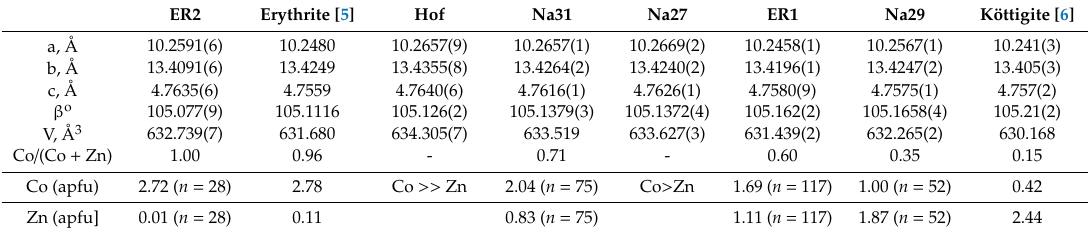
Table 7. Unit-cell dimensions calculated from X-ray powder di ff raction data for erythrite from Bou Azer, Morocco [5], köttigite from Schneeberg, Germany [6], and samples from